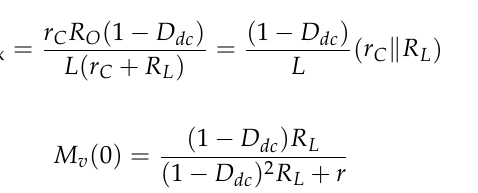
= 0.02. ( b ) Step response of v o , ac due to v B , ac = 2